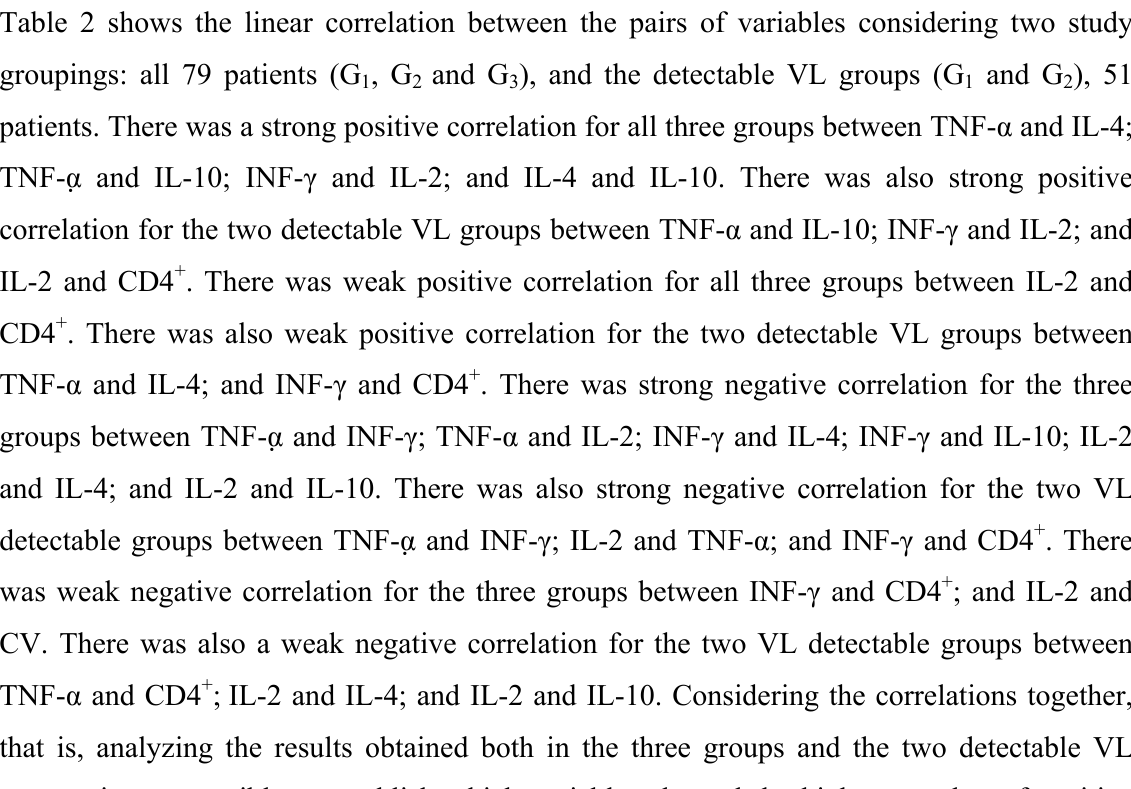
D. A. Meira et al . CORRELATION BETWEEN CYTOKINE SERUM LEVELS, NUMBER OF CD4 + T CELLS/mm³ AND VIRAL LOAD IN HIV-1 INFECTED INDIVIDUALS WITH OR WITHOUT ANTIRETROVIRAL THERAPY.